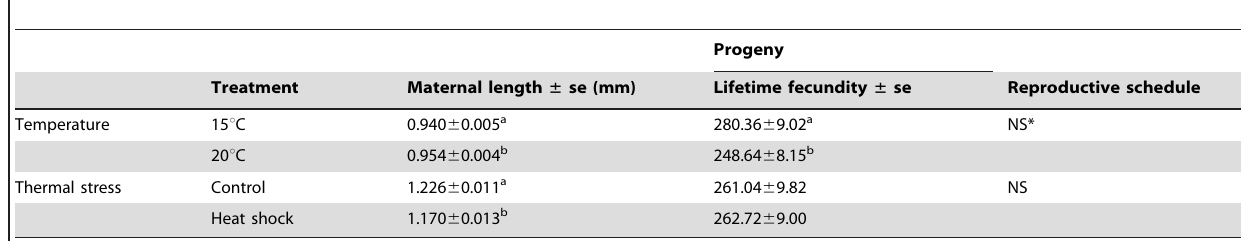
Table 1. Maternal size and progeny reproduction in worms grown at differing temperatures and exposed to heat stress.